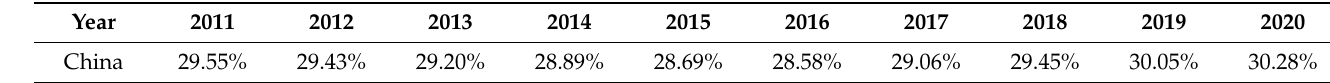
Table 2. The non-grain ratios of China during